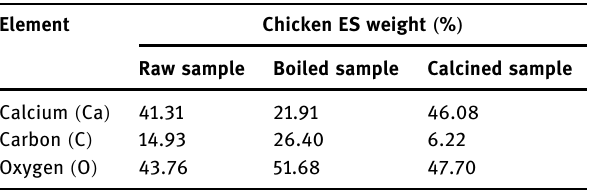
Table 1: Chemical compositions of ES particles with various treat